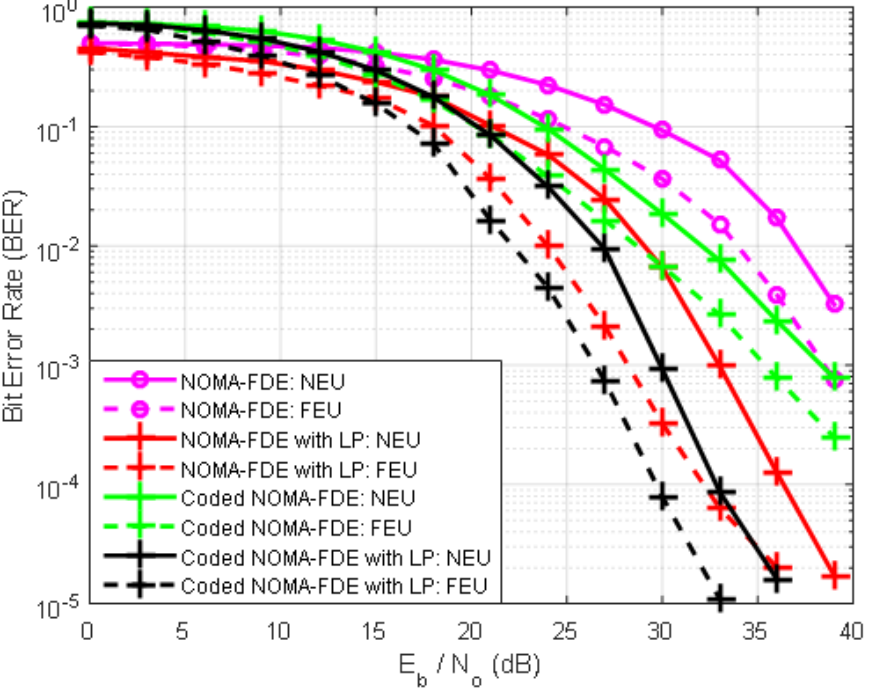
Figure 18. BER comparison of un-coded MC-NOMA and coded MC-NOMA with and without WHT in the presence of AWGN and impulse